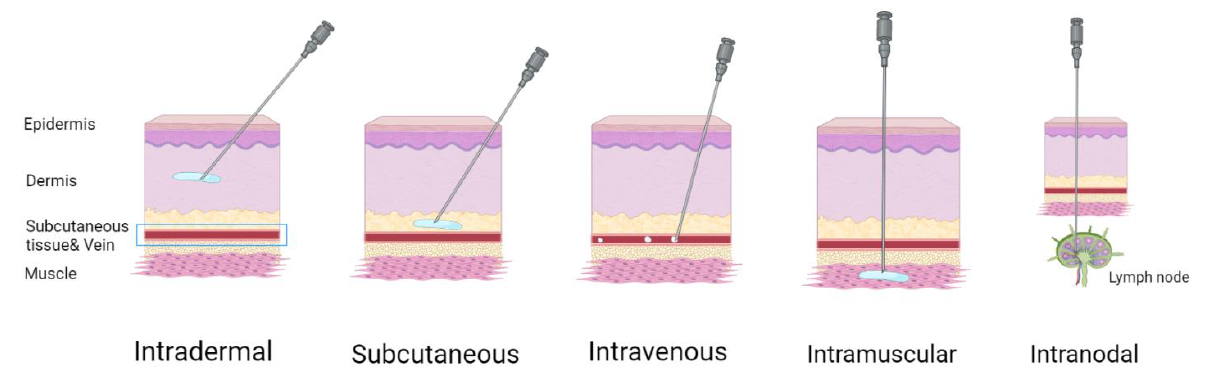
Figure 7. Administration routes of mRNA vaccines. Figure was created using BioRender